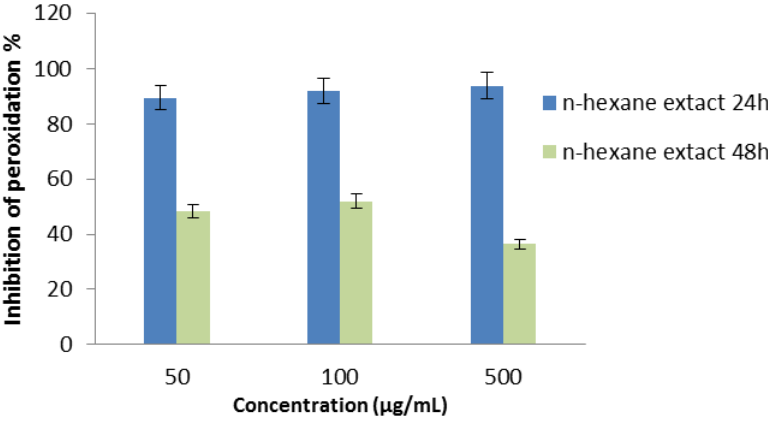
Figure 7. Inhibition of linoleic acid peroxidation of the hexane extract of the leaves of P.auritum determined by ferric thiocyanate